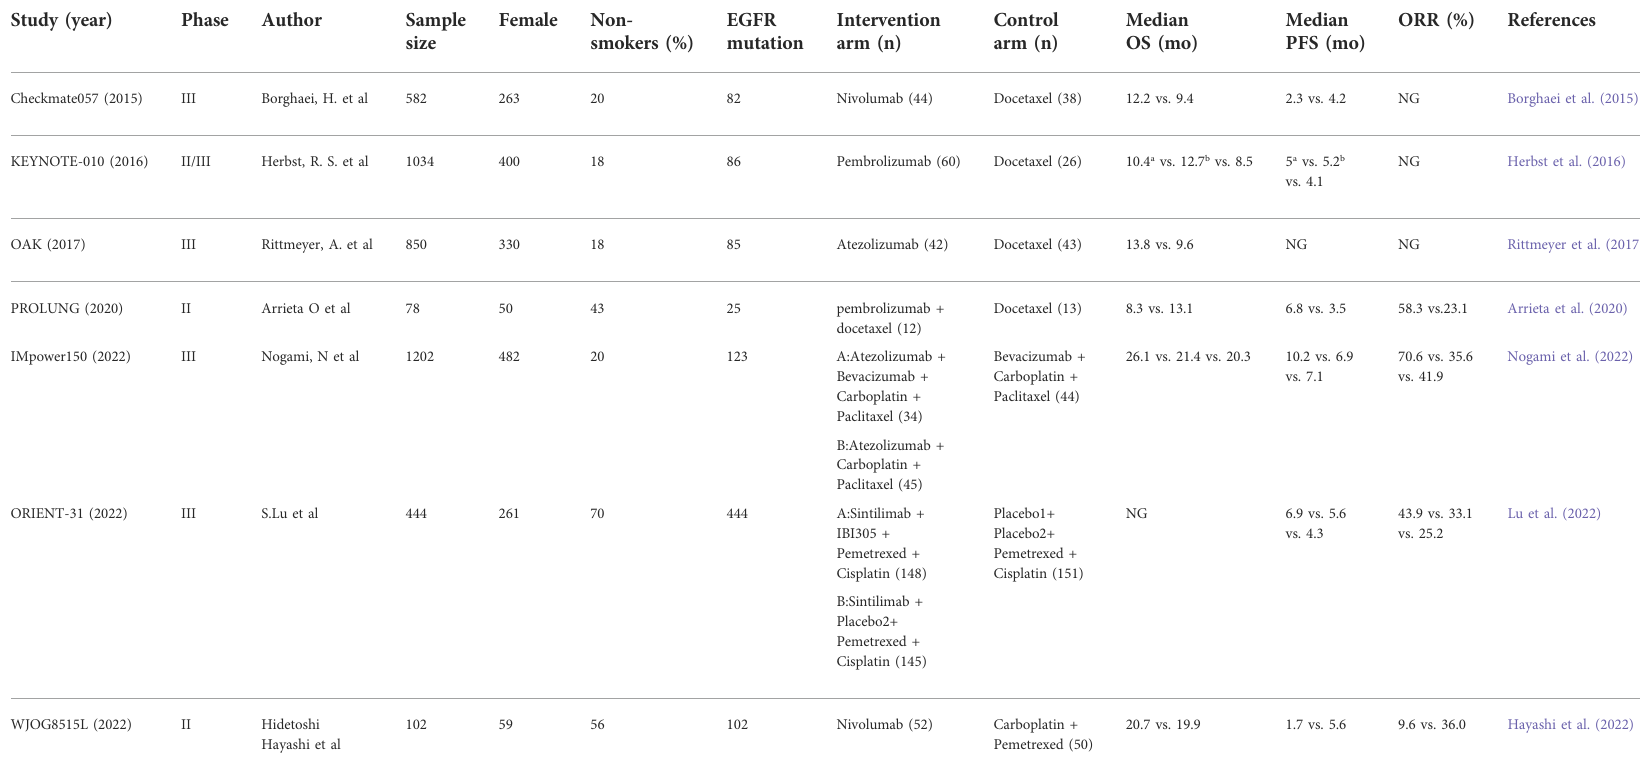
TABLE 2 Characteristics of the studies included in the